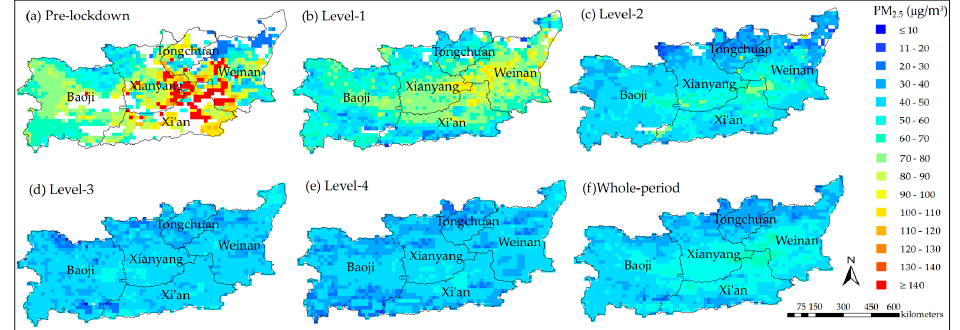
Figure 9. Maps showing the spatial distributions of the PM 2.5 concentrations in the Guanzhong Basin as predicted by the GTWR model, averaged for each stage before and after the COVID-19 outbreak: Pre- lockdown stage ( a ), Level-1 stage ( b ), Level-2 stage ( c ), Level-3 stage ( d ), Level-4 stage ( e ) and over the whole study period ( f ) from 1 January to 24 June in 2020.